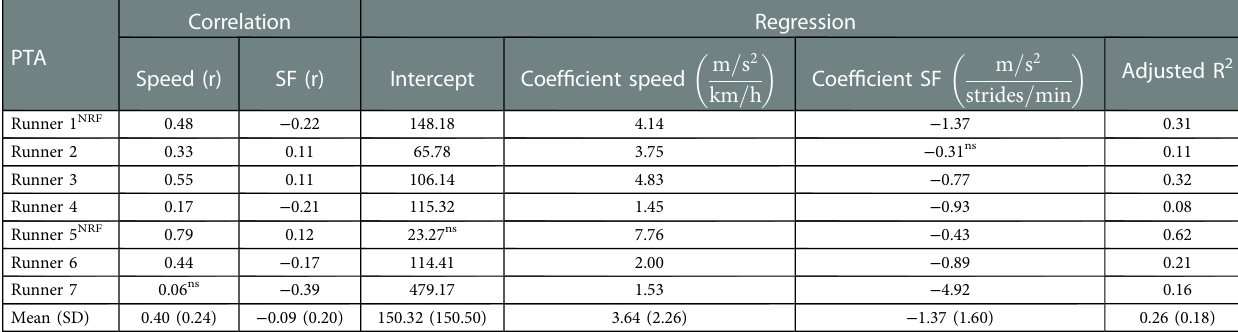
TABLE 1 Left side of table: individual correlations of peak tibial acceleration (PTA) with speed and stride frequency (SF). Right side of table: Individual regression equations to predict PTA based on speed and stride frequency together with the adjusted R-squared value (i.e., explained variance of regression equation). r, Pearson ’ s correlation coef fi cient; SD, standard deviation; ns, non-signi fi cant fi nding; NRF, non-rearfoot striking